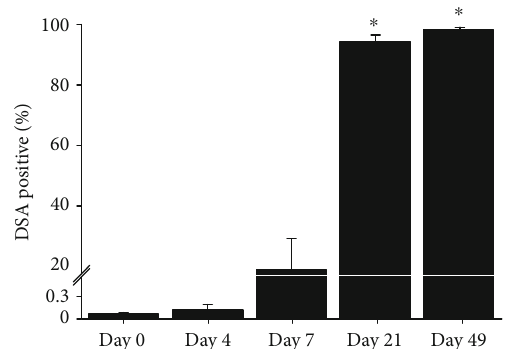
Figure 5: Rat-speci fi c immune response: graft therapy. The graft- speci fi c IgG antibody (donor-speci fi c antibody (DSA)) response was evaluated in graft-treated rat serum ( n = 7 -8) at days 0, 4, 7, 21, and 49 post-graft implantation. A subphysiologic amount of DSA was detected on hiPSC-CMs and fi broblasts at days 0 and 4, with a stepwise increase between days 7 and 49 (1 μ L plasma:100 μ L cellular suspension). Despite the presence of these graft-speci fi c antibodies, reversal of maladaptive remodeling was observed in graft-treated rats. ∗ Unpaired t -test versus day 7, p < 0 : 05